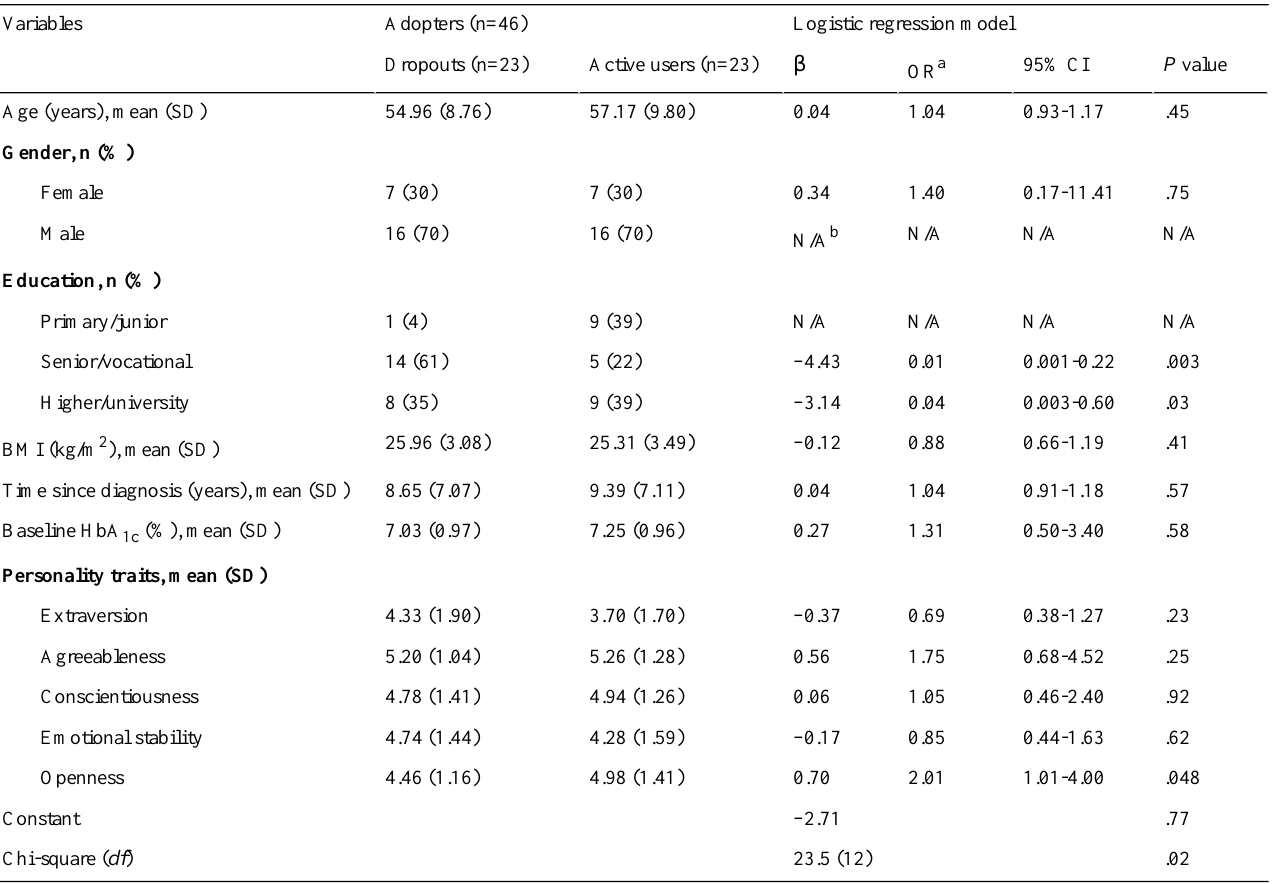
Table 3. Logistic regression for personality traits associated with active utilization.